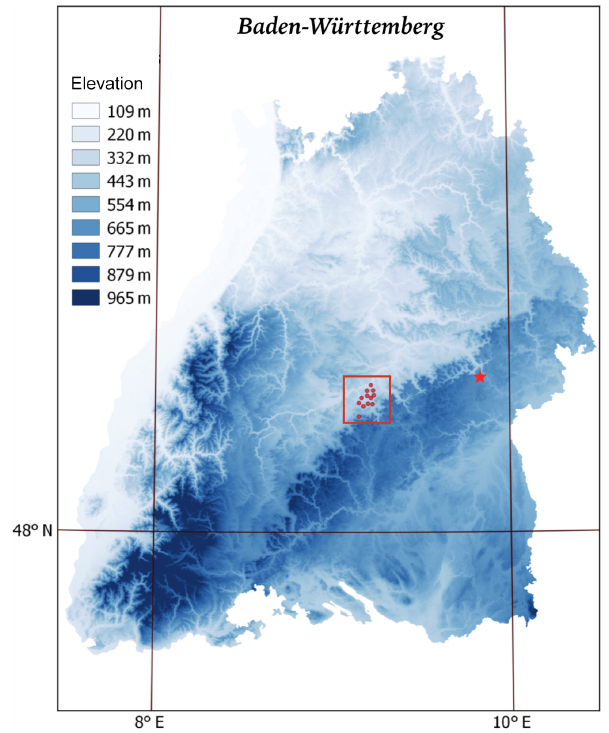
Figure 2. The elevation map of Baden-Württemberg with the study domain marked by the red square, the rain gauges marked by the red dots, and the site of Radar Türkheim marked by the red